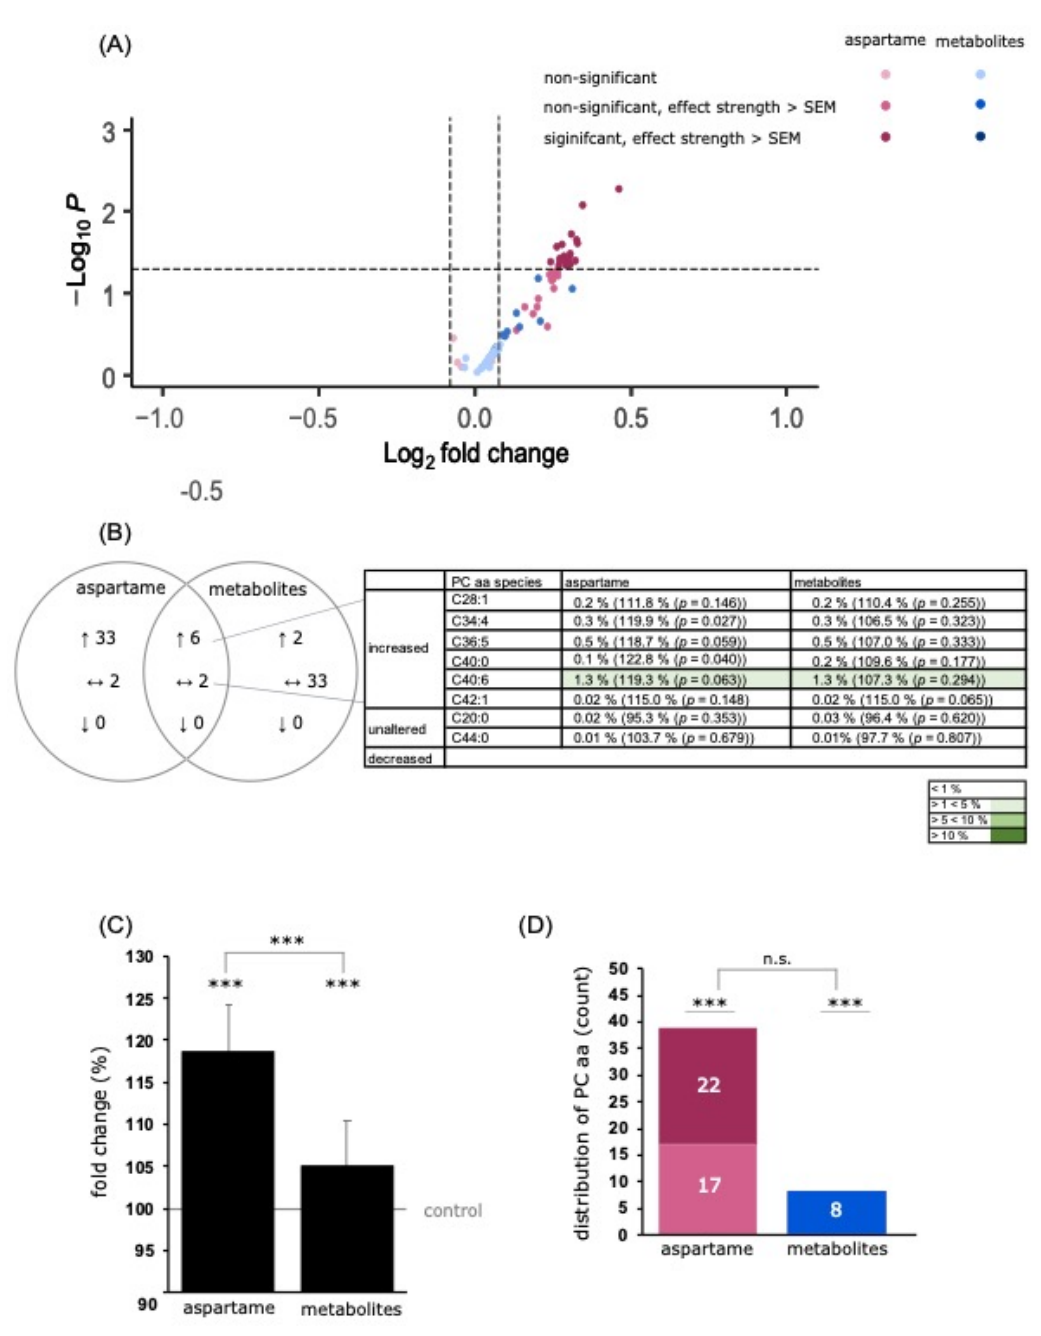
Figure 5. Effects of aspartame or aspartame metabolites on phosphatidylcholine (PCaa) species. Neuroblastoma cells (SH-SY5Y) were treated as described before with control, aspartame, or aspar- tame metabolites for 48 h and analyzed using a semi-quantitative shotgun lipidomics approach. Each diagram represents the changes in the aspartame- or metabolite-treated cells in comparison to control-treated cells. ( A ) In the volcano plot, each PCaa species is graphically represented by a pink (aspartame treatment) or blue (aspartame metabolite treatment) dot which is plotted with its fold change ( x -axis) against its according p -value ( y -axis). The volcano plot is structured as the one in Figure 4. ( B ) Venn diagram of PCaa species after incubation of SH-SY5Y cells with aspartame or aspartame metabolites. Alterations of the same species are visible in the overlapping part. ( C ) The bar chart shows the relative fold change of all measured PCaa species after aspartame treatment compared to treatment with aspartame metabolites. Error bars represent the standard error of the mean (SEM), and the statistical signi fi cance was set as *** p ≤ 0.001. ( D ) Distribution of PCaa species, classi fi ed by the amount of increased or decreased PCaa species. The bar chart is structured as the